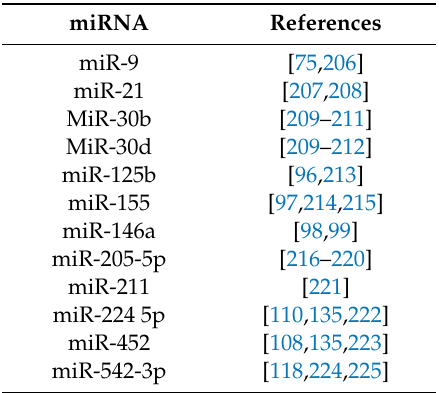
Table 4. The most representative miRNAs with an opposite role in melanoma and other